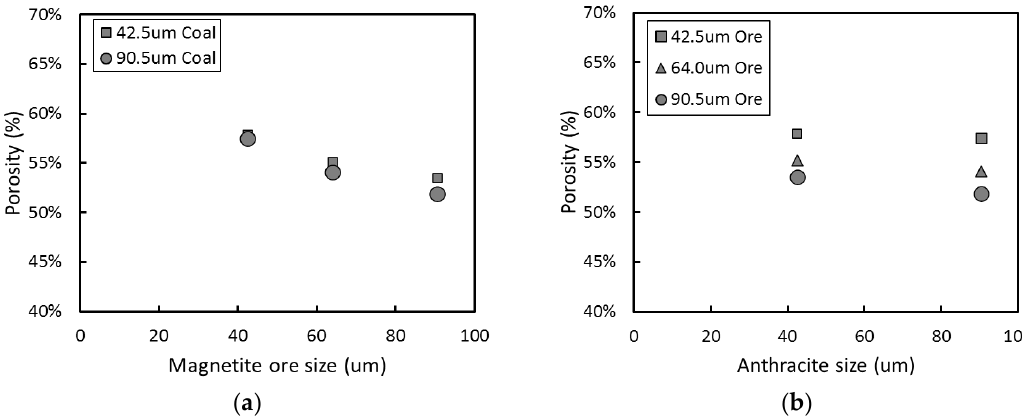
Figure 6. Relationship between porosity of the reduced pellets and particle size: ( a ) iron ore ( b ) coal.